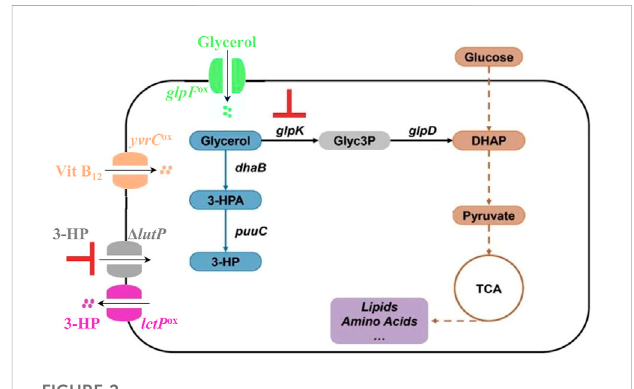
FIGURE 2 Overview of the genetic modi fi cations performed in the PS. We over-expressed the genes glpF (for improved import of glycerol), yvrC (for improved import of coenzyme B 12 ), lctP (for improved export of 3- HP), and knocked out the gene lutP (to import of